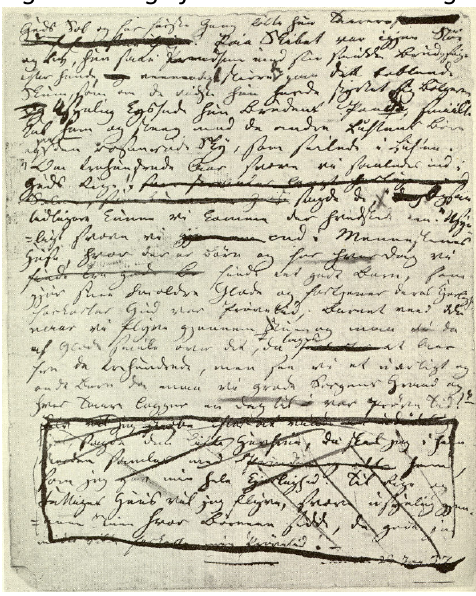
Figure 5. Page from Andersen’s autographed manuscript